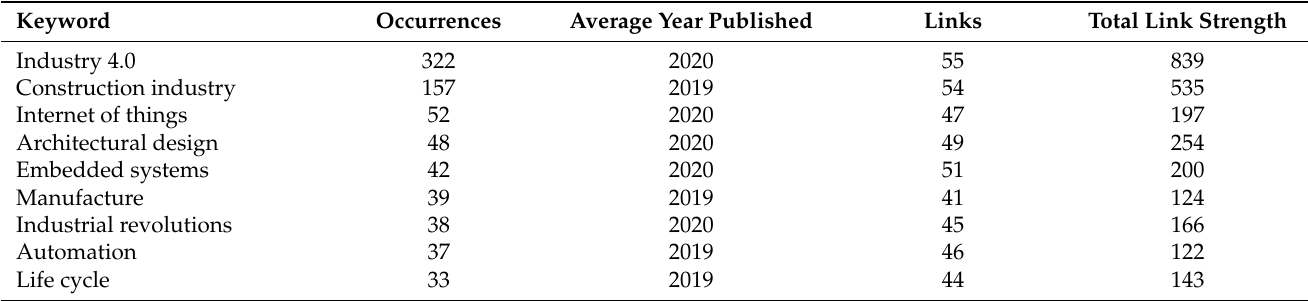
Figure 13. Network map of co-occurring keywords for Industry 4.0 in construction (2006 – 2022). Table 8. List of selected keywords and relevant network data for Industry 4.0 in